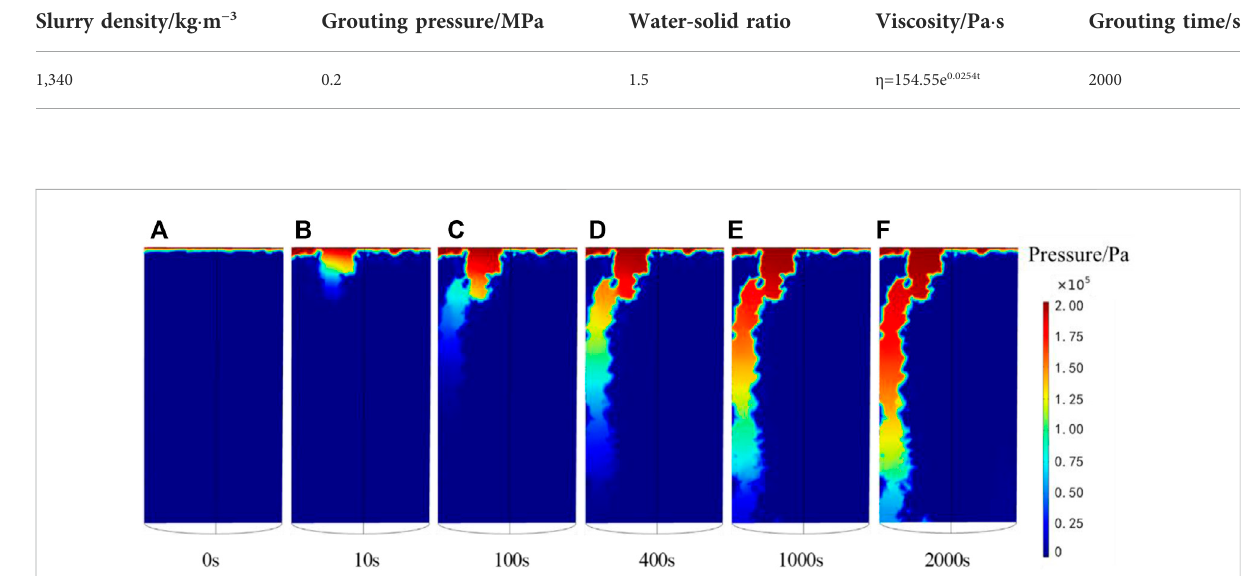
TABLE 2 Main parameters of numerical simulation.